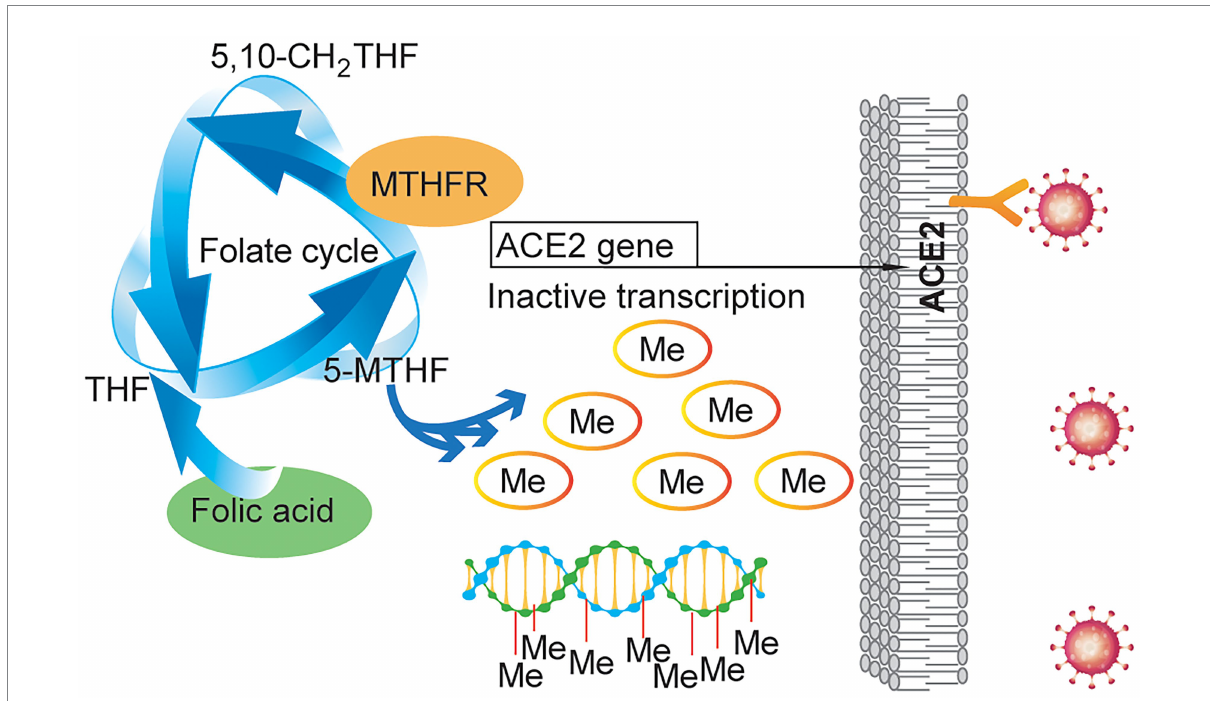
FIGURE 6 Schematic illustrating the effect of folic acid on SARS-CoV-2 invasion. MTHFR regulates ACE2 expression by changing its promoter methylation level, and folic acid can alter SARS-CoV-2 transmissibility and SARS-CoV-2-neutralizing antibody